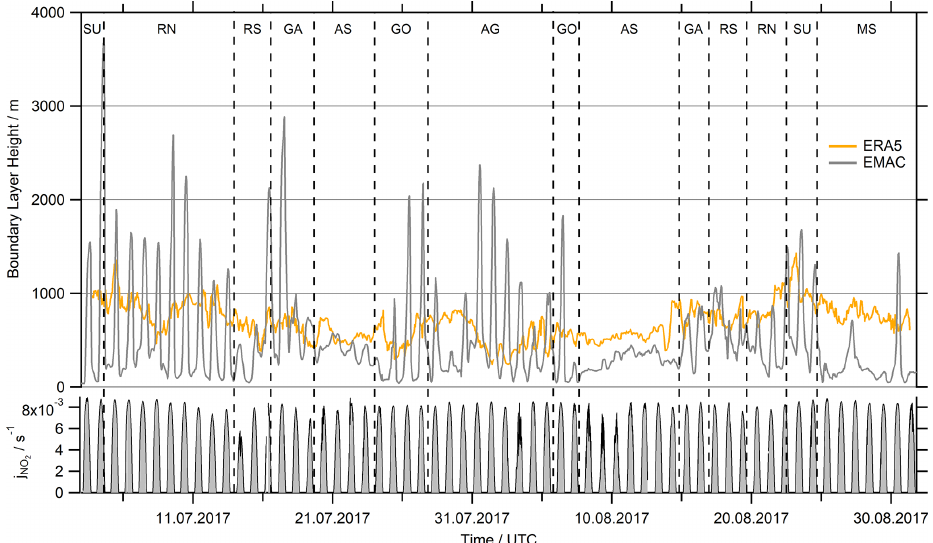
Figure 9. Comparison of the simulated h BL in EMAC with ERA5 (fifth-generation ECMWF reanalysis) data at a resolution 4 times higher (31km grid) than EMAC ( ∼ 110km grid) and hourly averaged data. EMAC’s h BL indicates continental influence by the strong diurnal variation while cruising close to the coast (SU, RN, GA, GO and AG), with the highest values determined for the ports of Jeddah (10– 13 July), Djibouti (16 July) and Kuwait (1–3 August). The measured photolysis frequency j NO during